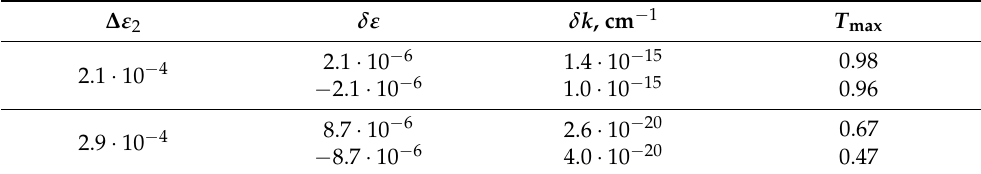
Table 3. The widths of transmission curves δ k and amplitudes of transmission coefficients T max